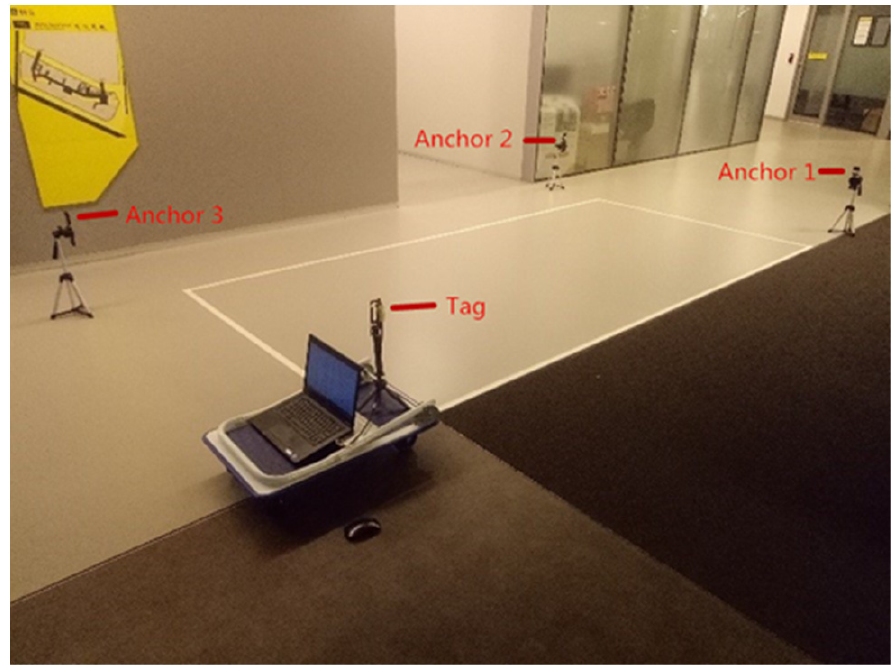
Figure 11. Testbed for UWB field experiment.